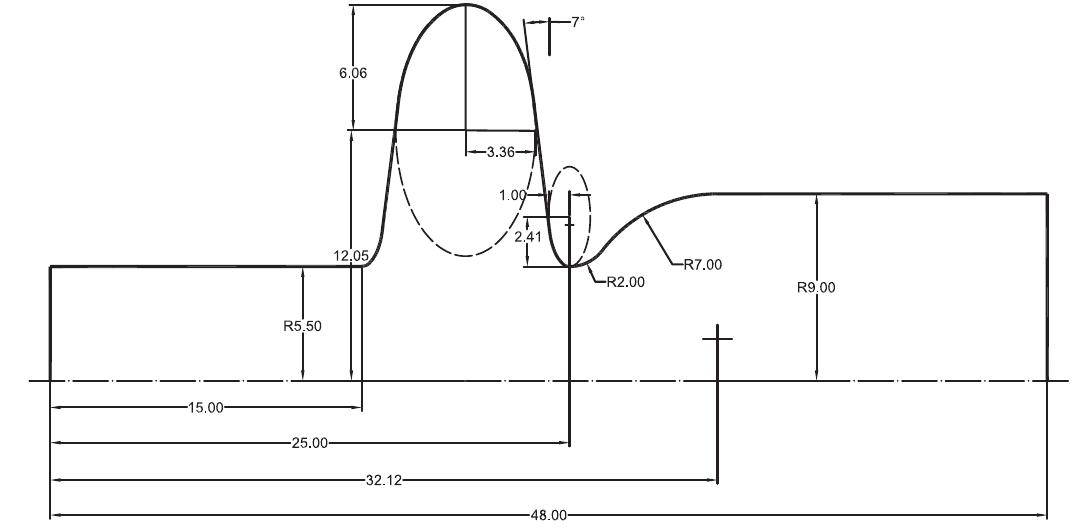
FIG. 6. Geometry of the β ¼ 0 . 5 SRF cavity. Dimensions are in centimeters.